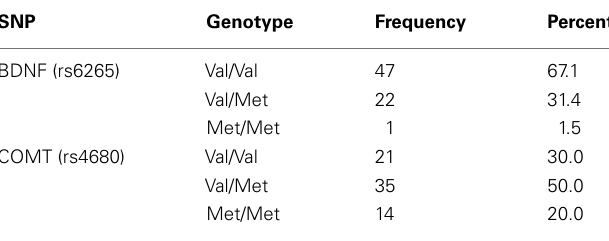
Table 2 | Genotype frequency for BDNFVal66Met,